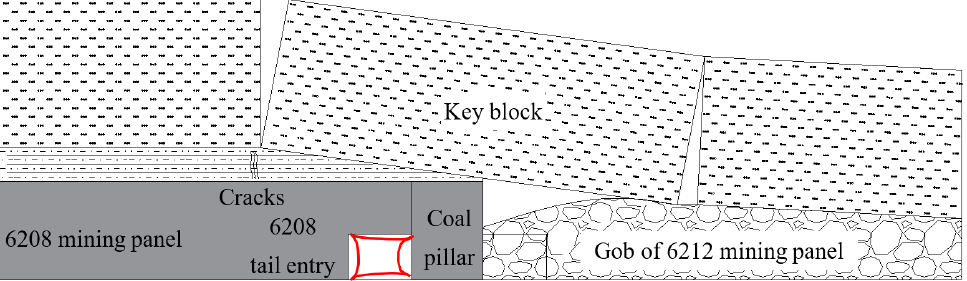
Figure 5. Schematic diagram of the key block lateral rotation of the main roof.